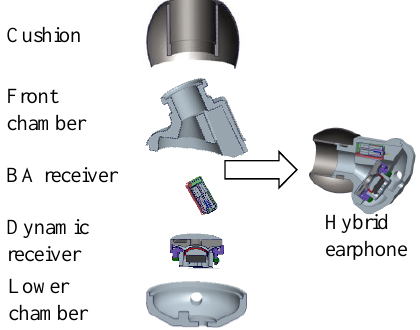
Figure 1. Hybrid earphone components.